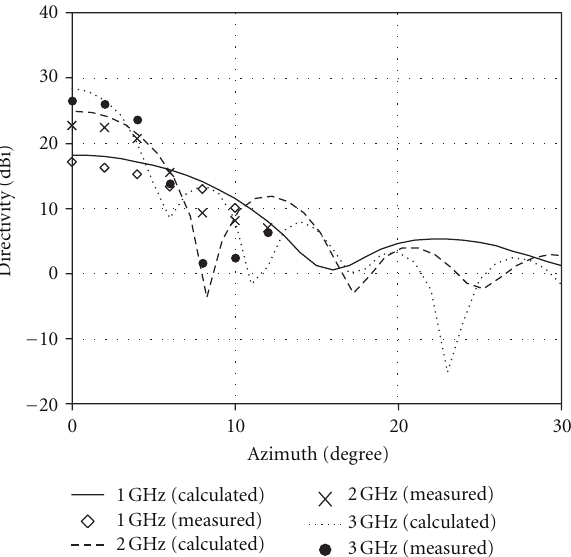
Figure 6: Comparison of measured radiation patterns and those of a simulation for N x = N y = N e = 1 with a narrow throat region. Simulation results show good agreement. Zero degree corresponds to the direction of the main beam.